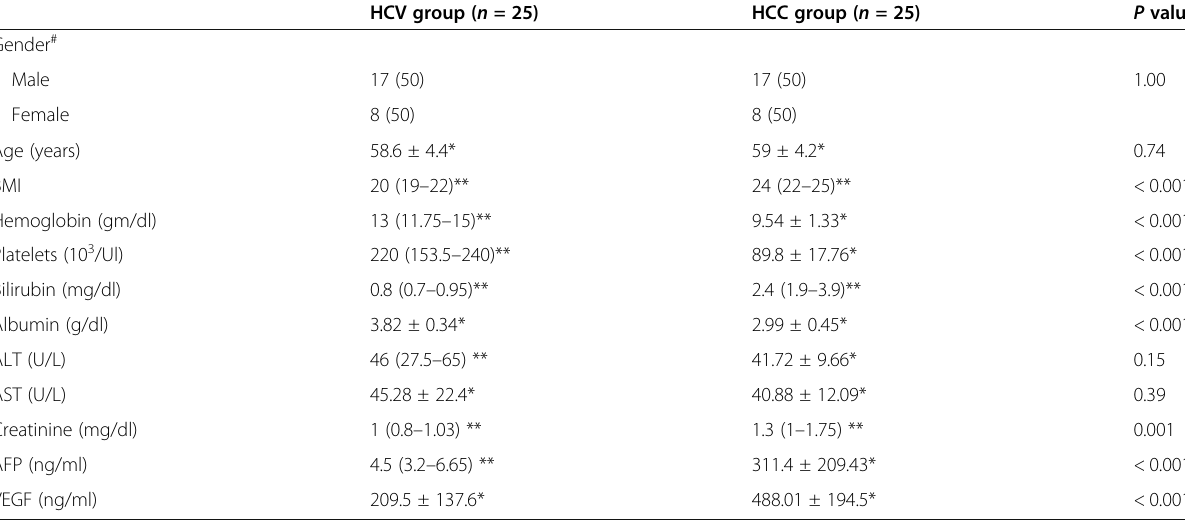
Table 1 Comparison between the 2 groups regarding demographic and laboratory